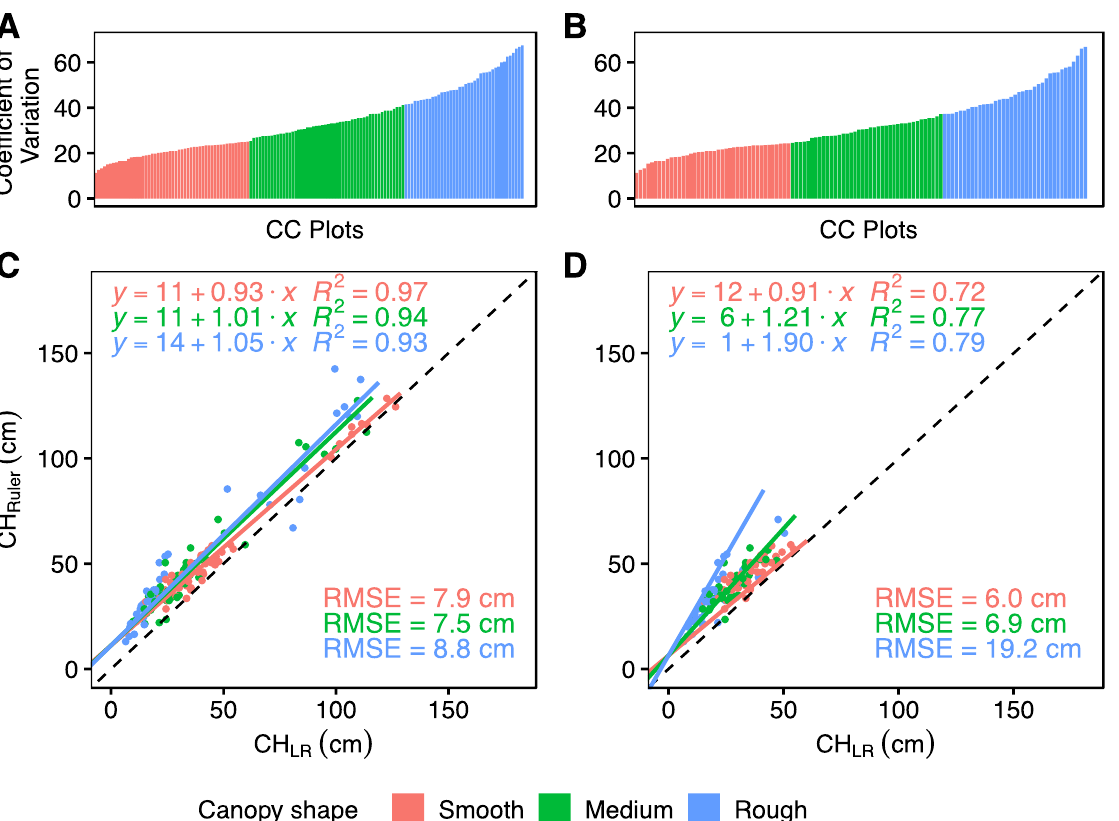
Figure 5. Clustered plots of cover crops into smooth, medium, and rough canopy shapes based on the coefficient of variation of canopy height for ( A ) the whole dataset and ( B ) for the dataset excluding plots containing mustard. Linear relationship between canopy height from low-resolution UAV mission (CH LR ) and manual height measurement with a ruler (CH Ruler ) for ( C ) the whole dataset and ( D ) the dataset excluding plots containing mustard. The sample sizes are 52, 52, and 44 in ( A , C ) and 44, 45, and 31 in ( B , D ) for smooth, medium, and rough canopies, respectively.